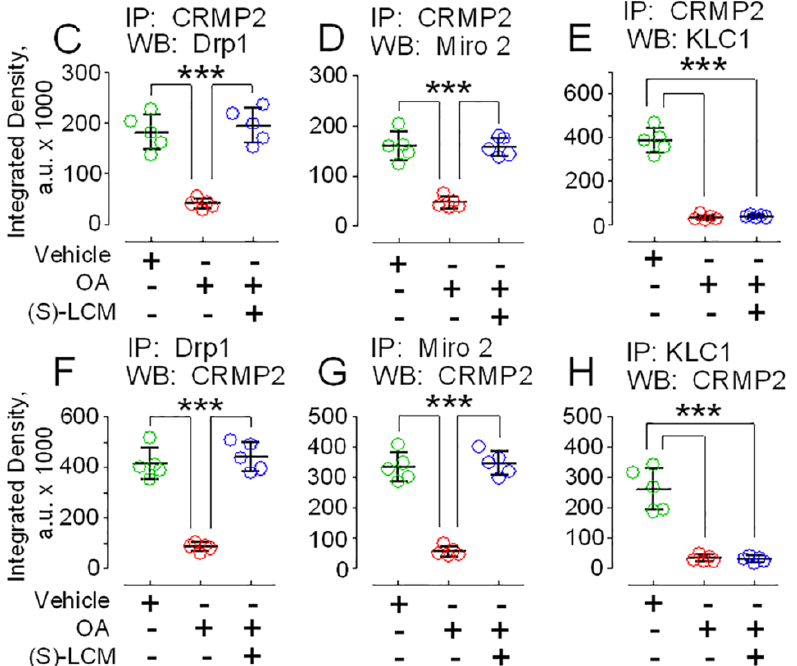
Figure 4. CRMP2 co-immunoprecipitated with Drp1, Miro 2, and Kinesin 1 light chain (KLC1) in lysates of mouse cultured striatal neurons. Incubation of neurons with okadaic acid (OA) disrupted CRMP2 binding to Drp1, Miro 2, and KLC1. (S)- lacosamide ((S)-LCM) prevented CRMP2 dissociation from Drp1 and Miro 2 but not from KLC1. In ( A ), immunoprecipi- tation (IP) with anti-CRMP2 antibody followed by Western blotting (WB) with anti-Drp1, anti-Miro 2, and anti-Kinesin 1 light chain (KLC1) antibodies, In ( B ), IP with anti-Drp1, anti-Miro 2, and anti-KLC1 antibodies followed by WB with anti- CRMP2 antibody. Neurons were treated with 20 nM OA alone or with 20 nM OA and 30 μ M (S)-LCM for 16 h. Here, 0.01% DMSO was used as a vehicle. The input was 5% of total protein used in the pull-down procedure. In ( C–H ), densitometry data are shown. The colored circles indicate data from individual measurements. Data are mean ± SD. *** p < 0.001 com- paring vehicle with OA or OA plus (S)-LCM, n = 5 separate, independent